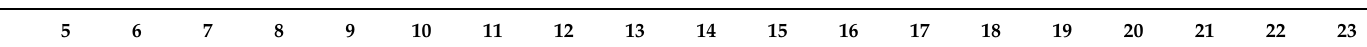
Table A2. Correlation matrix ( n =